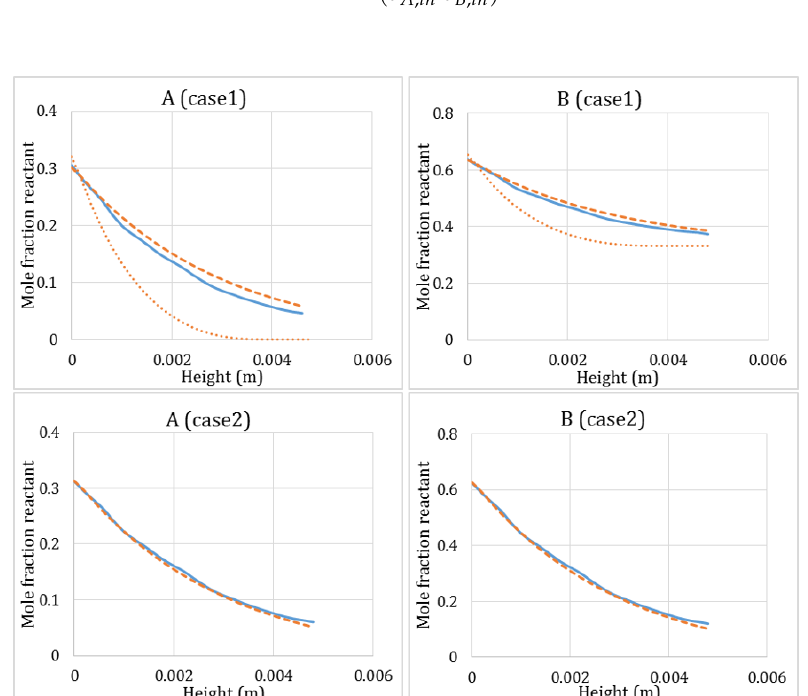
Figure 6. Comparison of the mole fraction of reactant (of specie A and specie B) for the simulated two cases, [Top] Case 1, and [Bottom] Case 2 from (i) PR-DNS (represented by solid lines); (ii) 1D model corrected (dashed lines); along the height of the reactor geometry. The dotted lines in Case 1 [Top] represent the predictions without adjusting the effectiveness factor as 𝜂 = (𝜂 𝐴−1 + 𝜂 𝐵−1 ) −1 .